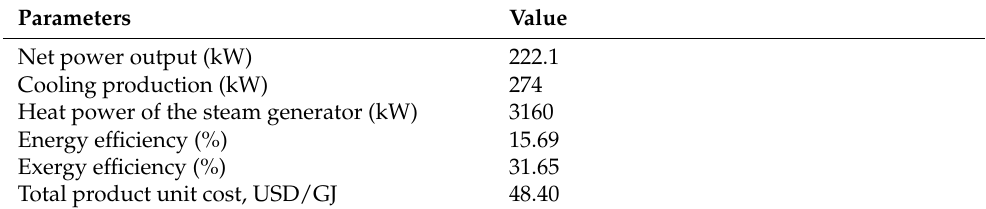
main performance indicators, thermodynamic and exergetic properties, as well as the unit cost of exergy flow at the various state points of the proposed system. Table 10. The indicators of the solar-based cogeneration system